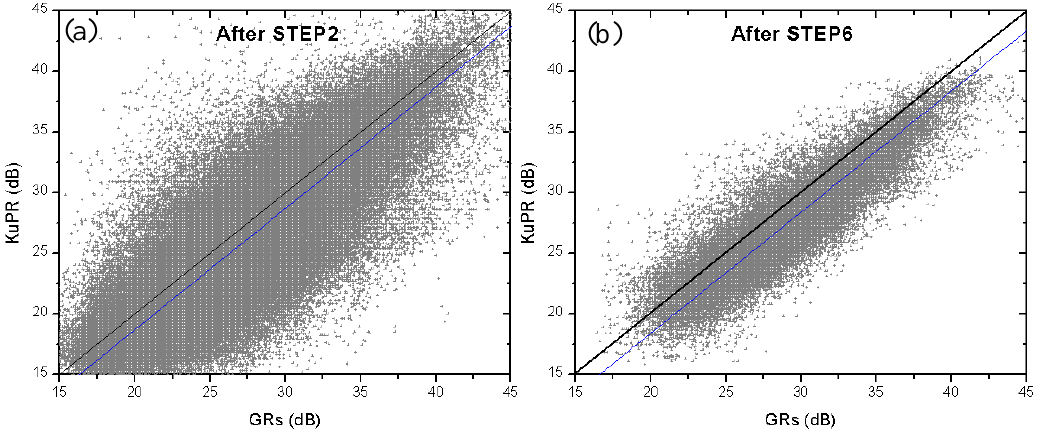
Figure 6. Scatter plot of KuPR and GR Mosaic Reflectivity. The blue line is the fitting line. ( a ) Original match-up dataset from STEP2. ( b ) Optimal match-up dataset from STEP6.